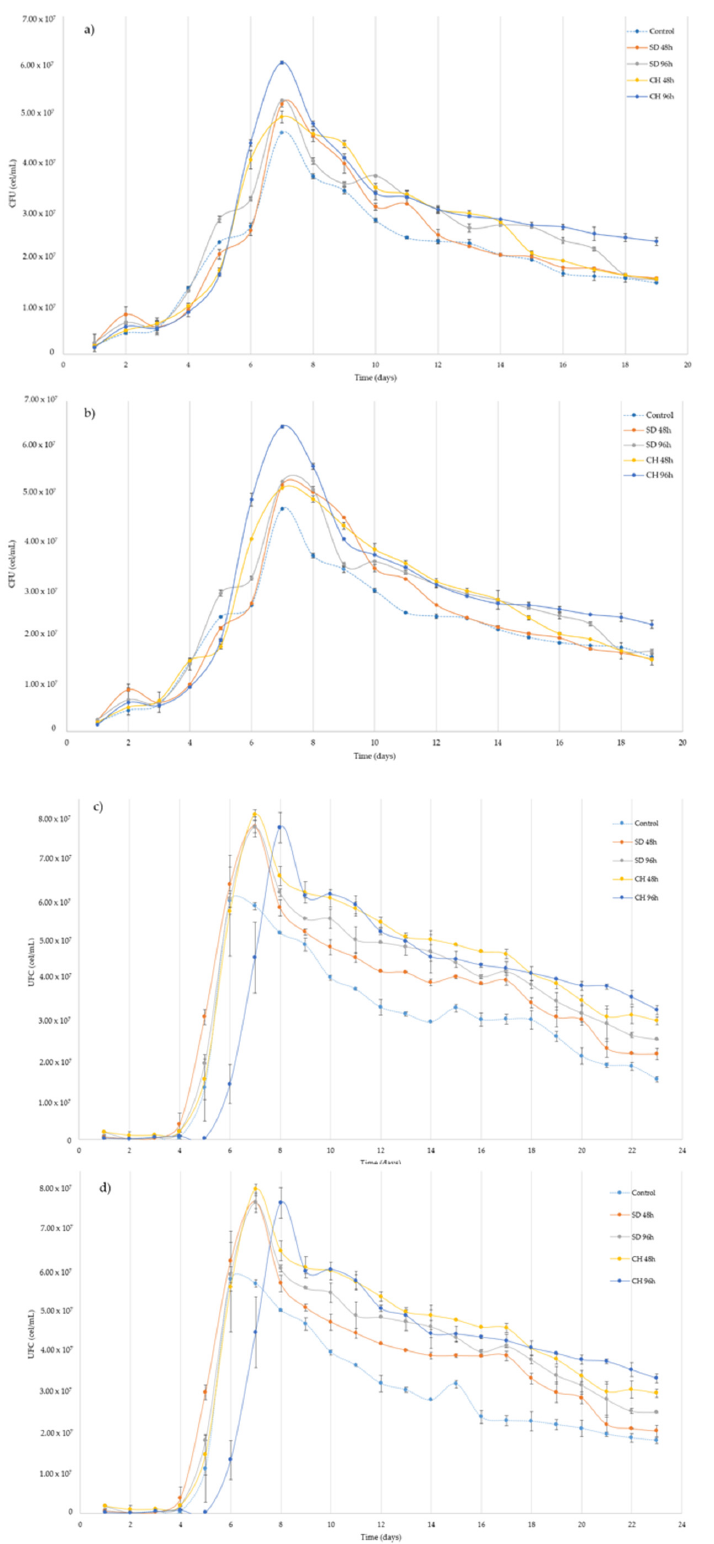
Figure 1. ( a – d ) Viable biomass development during grape must alcoholic fermentation without ( a , c ) and with ( b , d ) the presence of grape skins during two vintages (2018, a , b , and 2019, c , d ). Control: without over-ripening. SD48h: sun-dried grapes during 48 h. SD96h: sun-dried grapes during 96 h. CH48h: climatic chamber drying during 48 h. CH96h: climatic chamber drying during 96